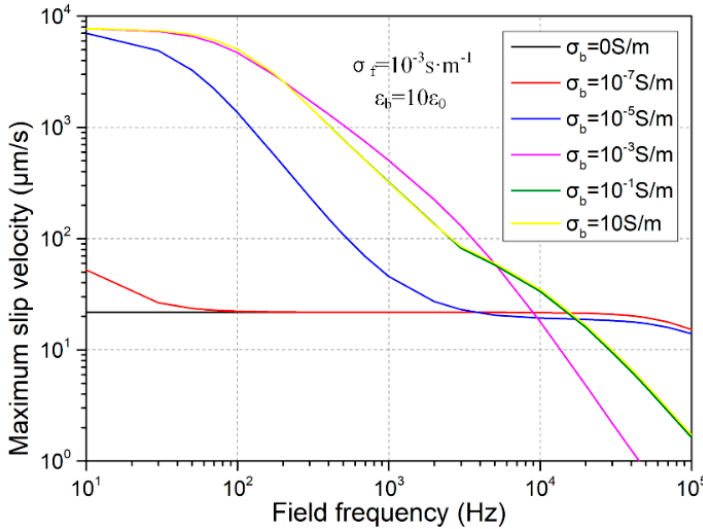
Figure 3. Frequency-dependent maximum ICEO slip velocity at the polarized phase interface for varying block conductivities.